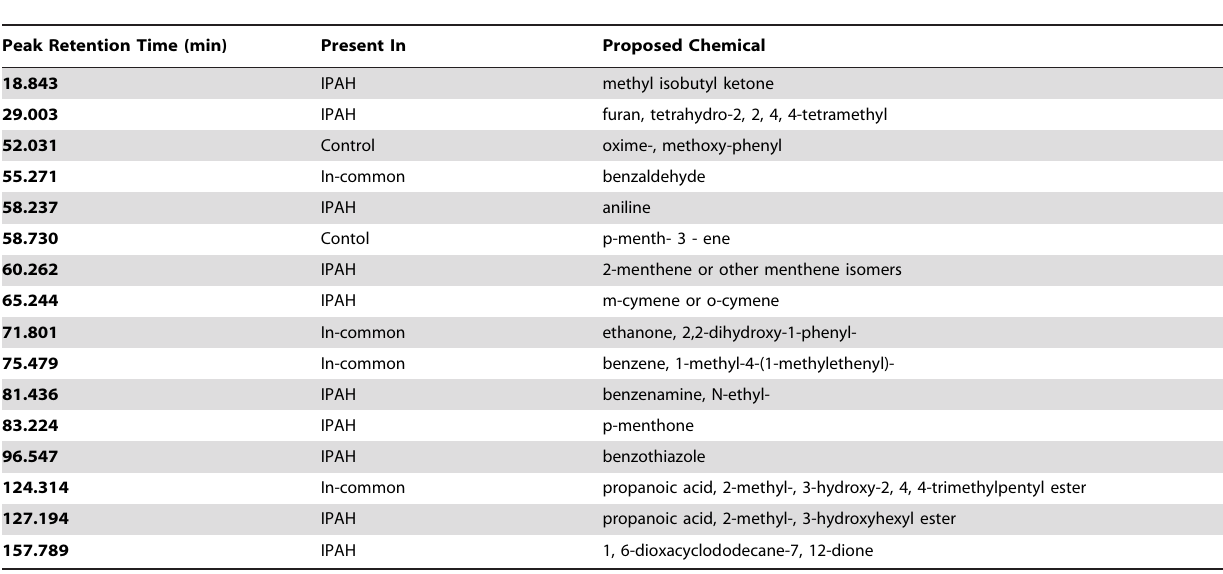
Table 3. Chemicals identified with ‘‘high confidence’’ for peaks found in all